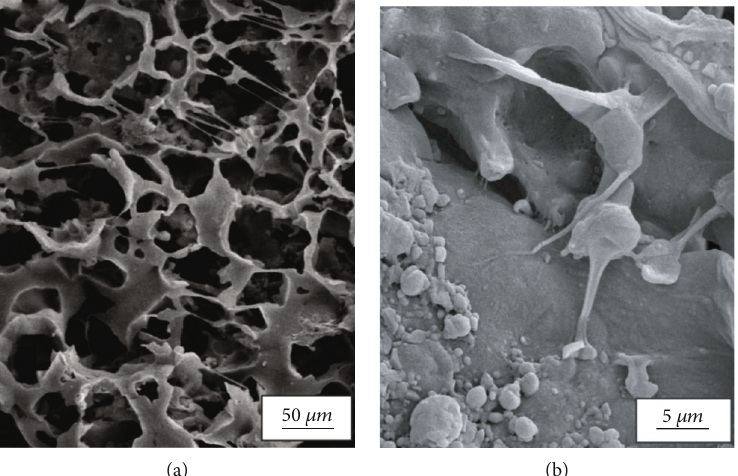
Figure 3: SEM images of (a) PCL/Gel/Chrysin sca ff old and (b) the adhered and expanded DPSCs on CL/Gel/Chrysin on day 3 after the start of culture.